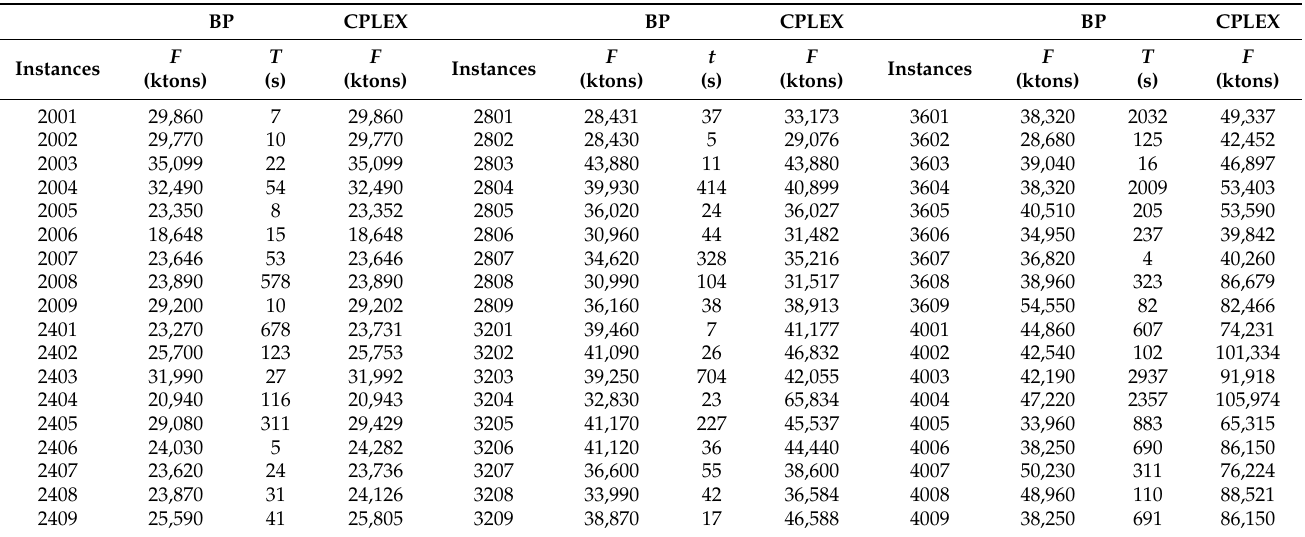
Table 2. Results of BP and CPLEX solving P 1 for 20–40 scale